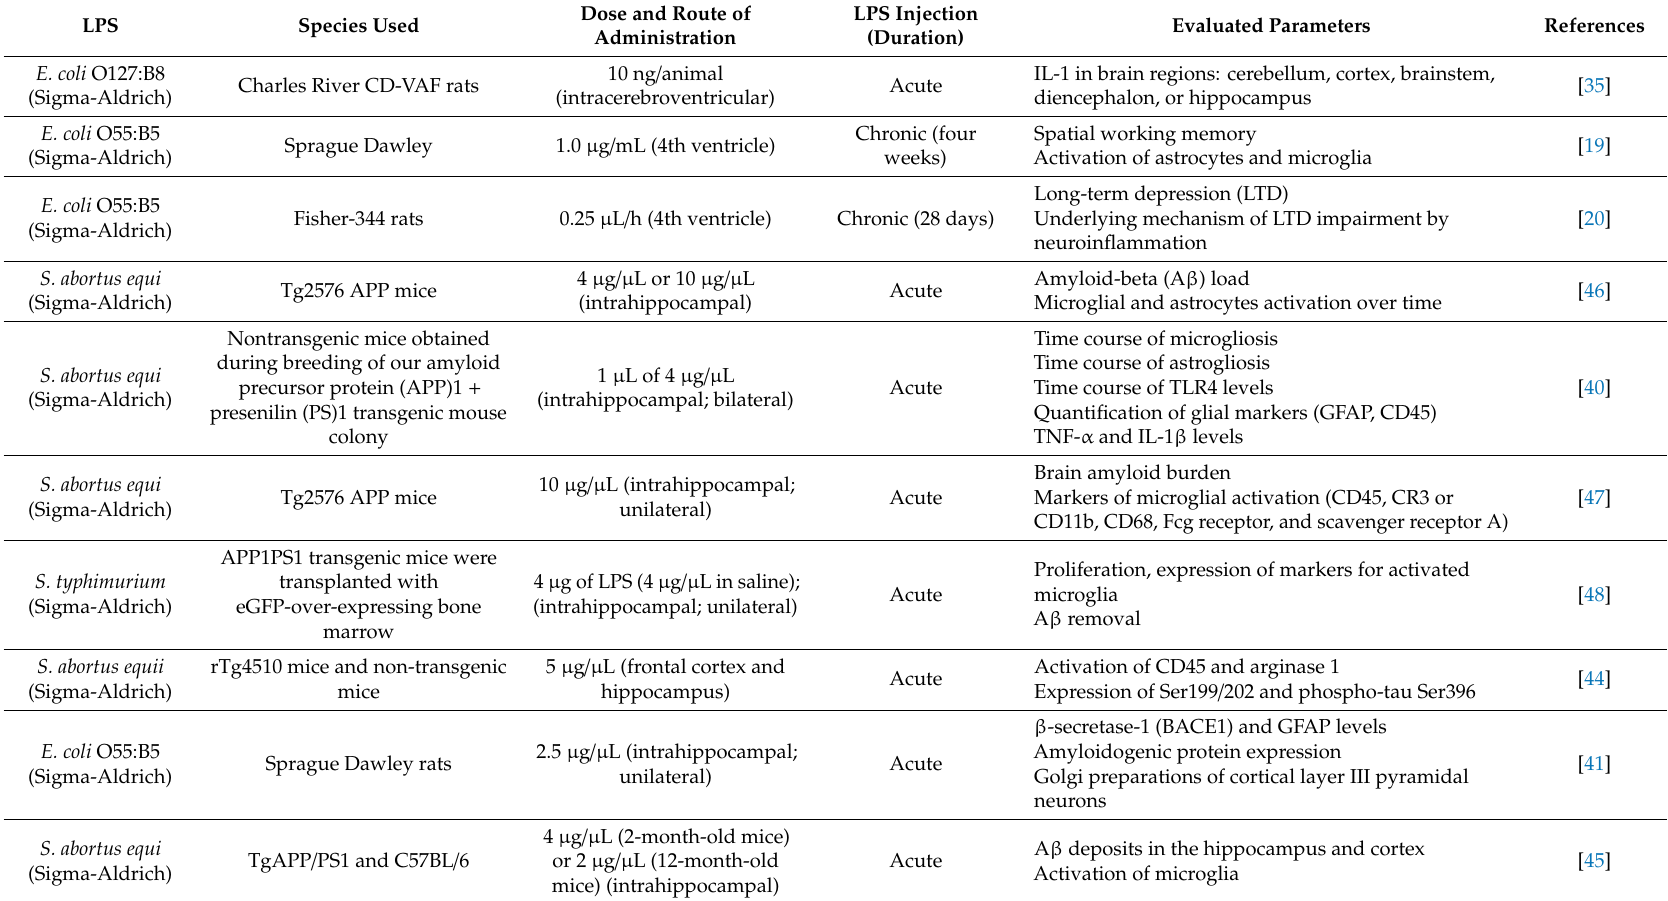
Table 1. Lipopolysaccharide (LPS) source, species used, dose and route of administration, duration, evaluated parameters of models of central LPS challenges for the elucidation of Alzheimer’s disease